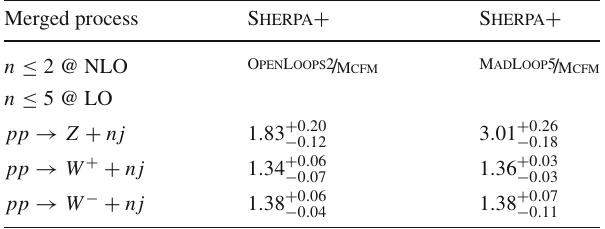
Table 3 CPU time ratios in an NLO multi-jet merged setup using S HERPA